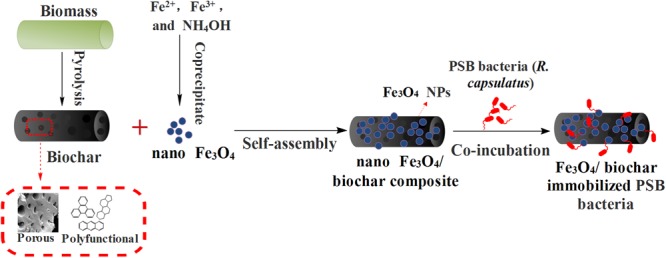
Scheme of preparation of Fe3O4/biochar composite and the immobilization of photosynthetic bacteria (PSB) bacteria.